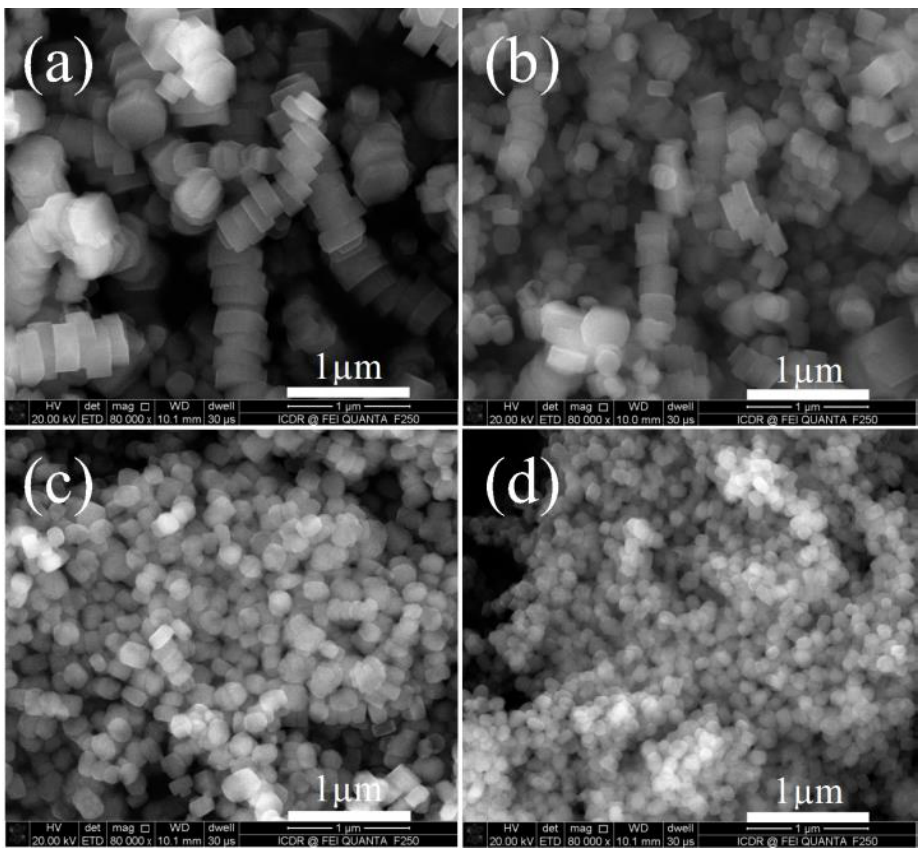
Figure 2. SEM images of ZSM-5 zeolite synthesized after evaporating ethanol for different time. ( a ) ZSM5—0 min; ( b ) ZSM5—20 min; ( c ) ZSM5—60 min; ( d ) ZSM5—120 min.